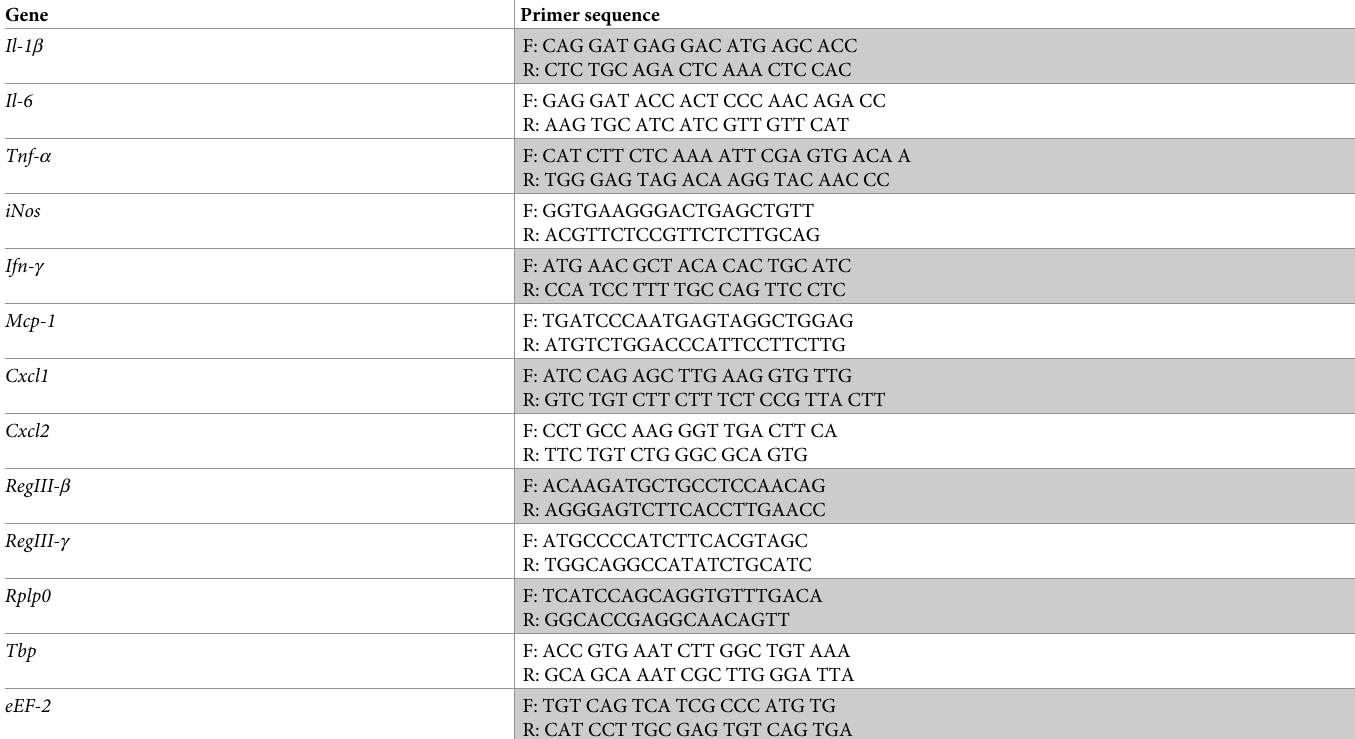
Table 3. Primers used for